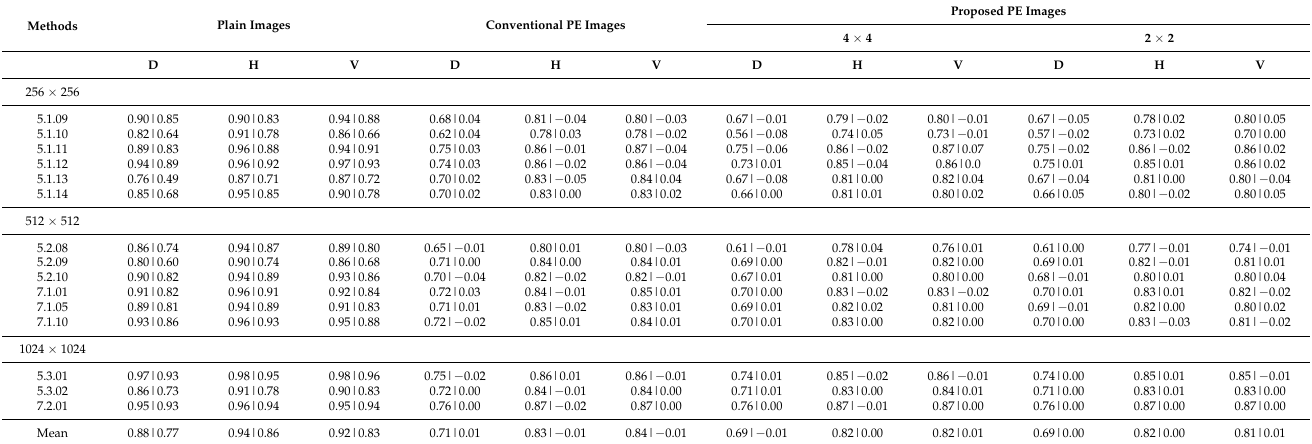
Table 1. Correlation coefficient (whole image|block level) analysis of perceptual encryption algo- rithms in diagonal (D), horizontal (H) and vertical (V)